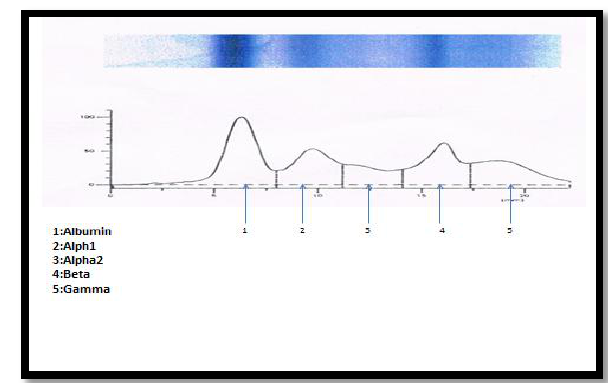
Figure, 3: Serum protein electrophoresis of rats treated with sodium fluoride (SF) and seed pomegranate oil (PSO) (T2).